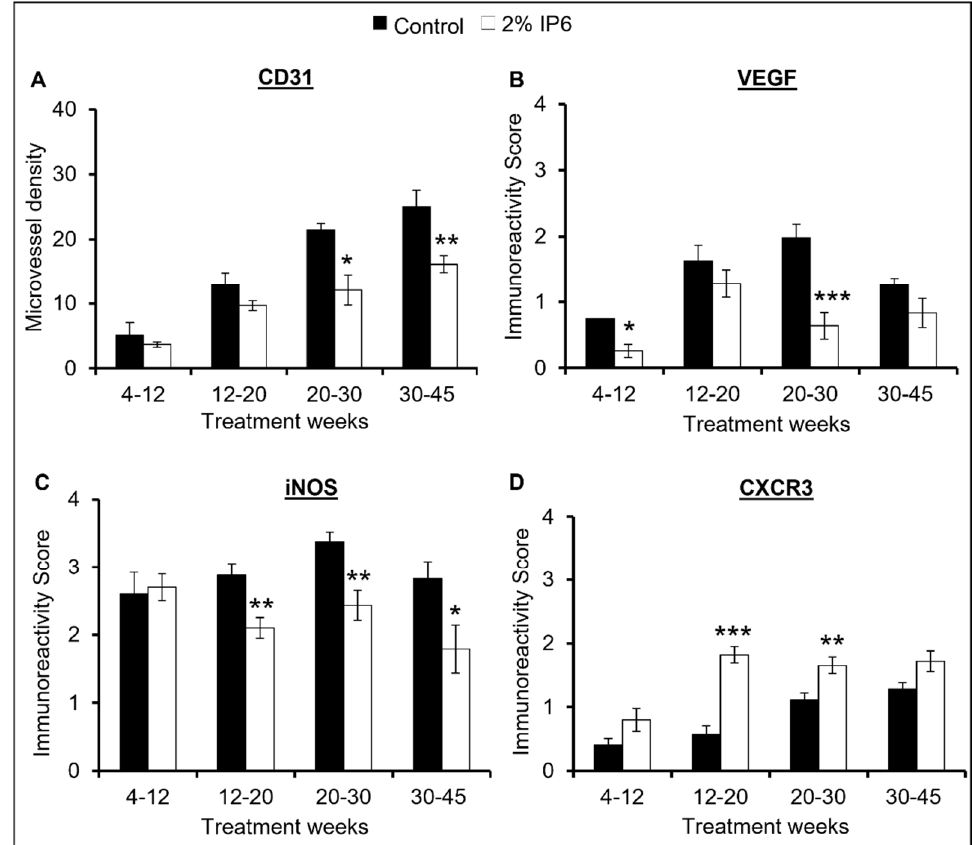
Figure 4. Stage-specific effect of IP6 feeding on angiogenic pathway in dorsolateral prostate of TRAMP mice. Effect on ( A ) microvessel density (MVD) as inferred by expression of PECAM-1/CD-31. MVD was determined by calculating the number of positive foci counted under × 400 magnifications in five selected areas in each section. Effect on ( B ) VEGF, ( C ) iNOS, ( D ) CXCR3 expression in TRAMP mice prostate and IP6-fed mice as determined by IHC. Quantified data are represented as mean ± SEM. *** p ≤ 0.001 , ** p ≤ 0.01 , and * p ≤ 0.05 .